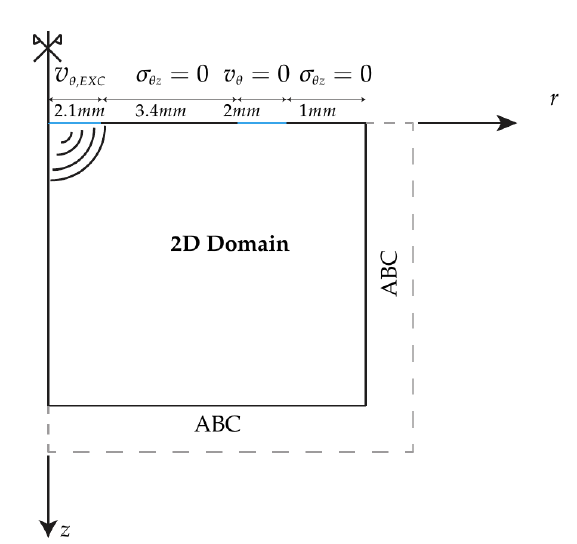
Figure 8. Spatial distribution of the boundary conditions of the model. 2D domain surrounded by absorbing boundary conditions, excitation, reception ( v θ = 0) and free surface conditions. Dimensions of the emitter, receiver, emitter-receiver and receiver-ABC.